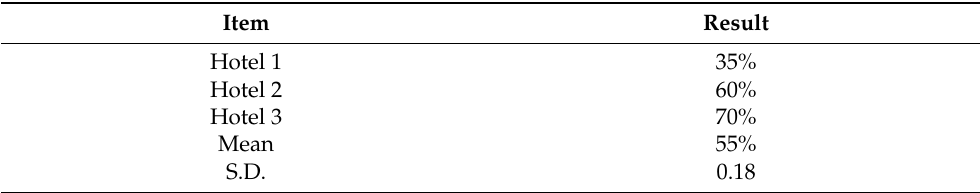
Table 13. What occupation average levels, as a percentage, do you currently have? Item Result Hotel 1 35% Hotel 2 60% Hotel 3 70% Mean 55% S.D.